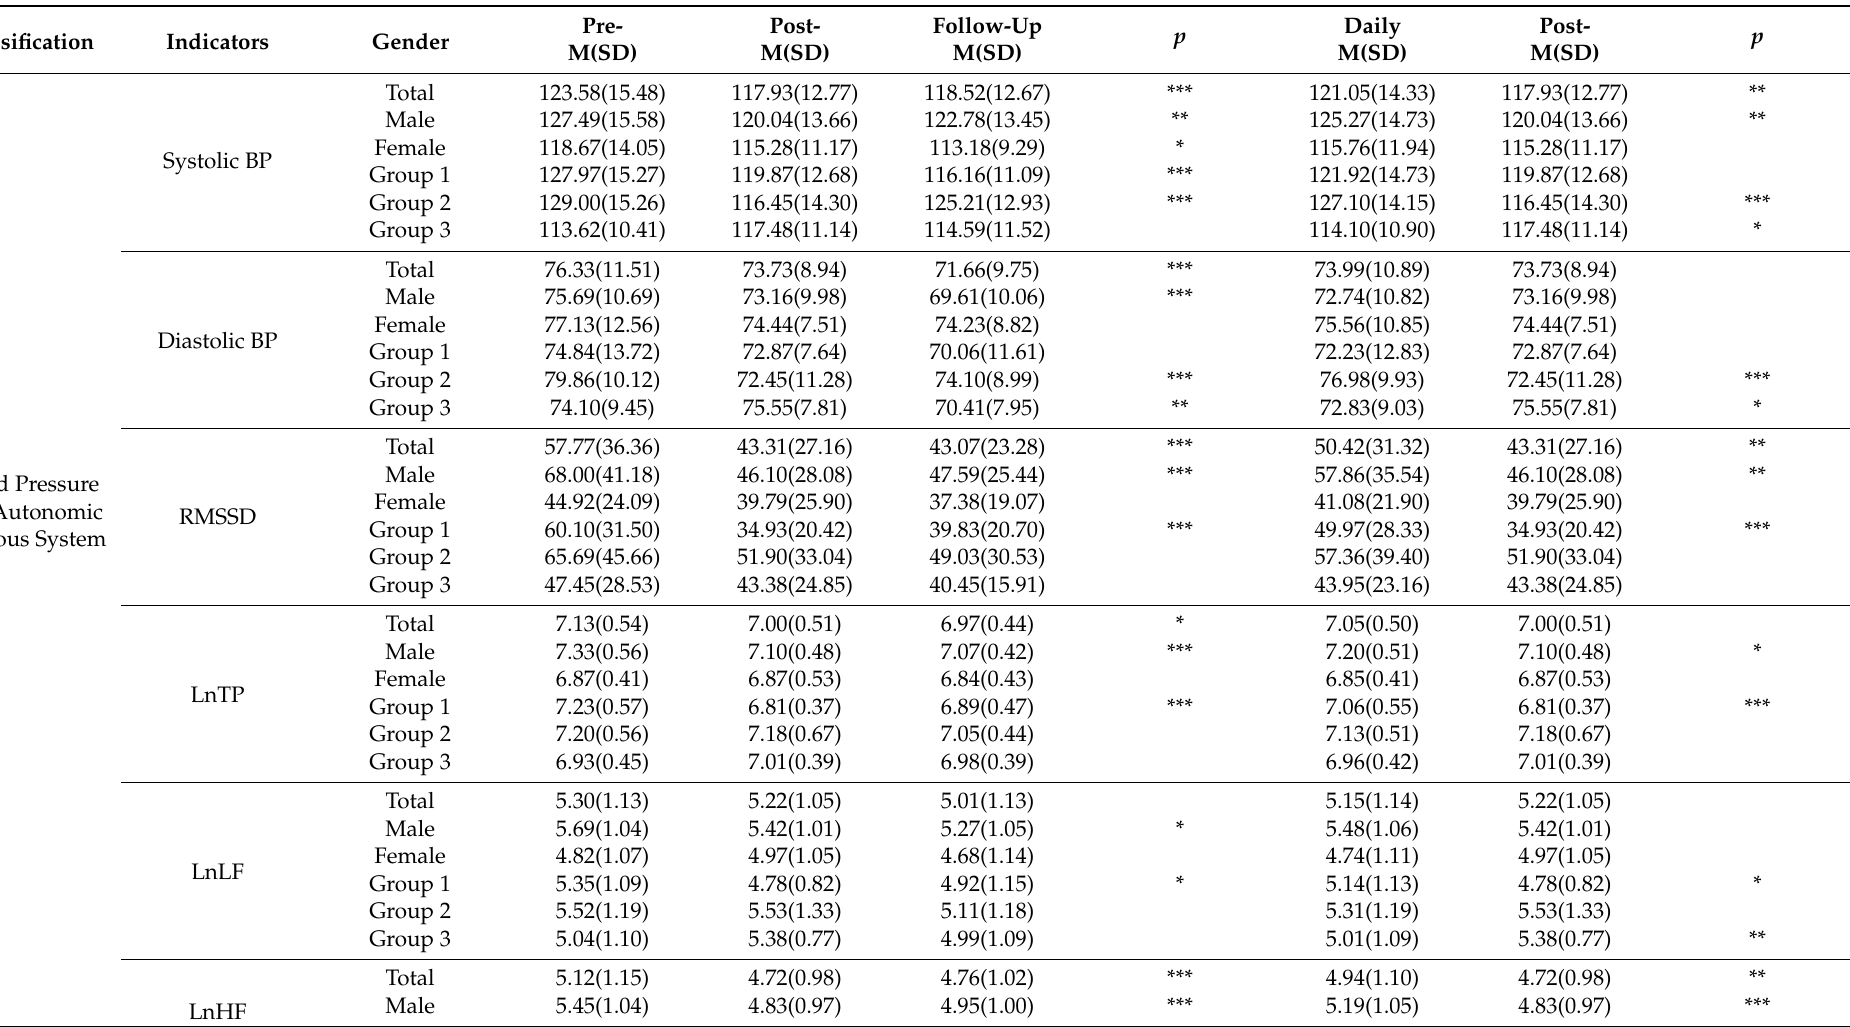
Table A1. Result Table of Descriptive Statistics, One-way RM ANOVA, and Paired t